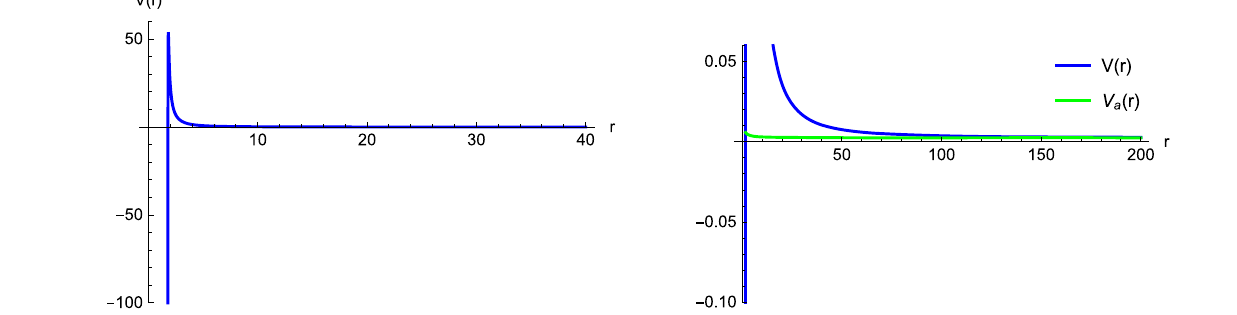
at r = r + . (Right) potential V ( r ) and its asymptotic potential V a ( r ) as functions of r ∈ [ r + , 200 ] . V a ( r ) mimics V ( r ) for very large r ≥ 150